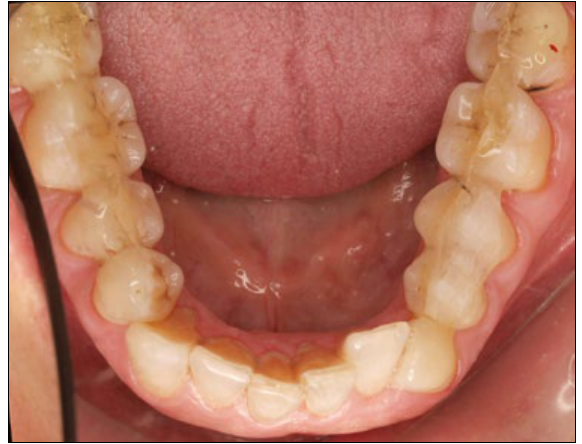
Figure 1. Triad Gel™ (Dentsply) applied to the buccal cusps of the lower posterior teeth.